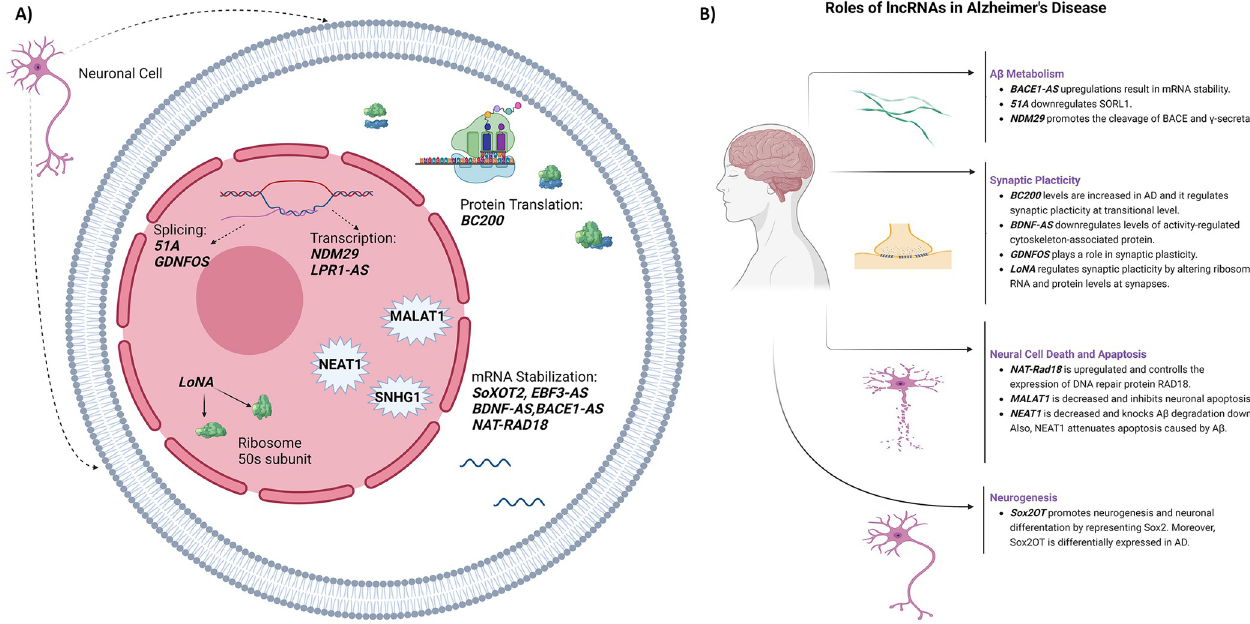
Fig 5. A: The roles of lncRNAs in neuronal cells in the pathogenesis of AD. B: The classification of roles for lncRNAs in AD. (made by biorender.com).